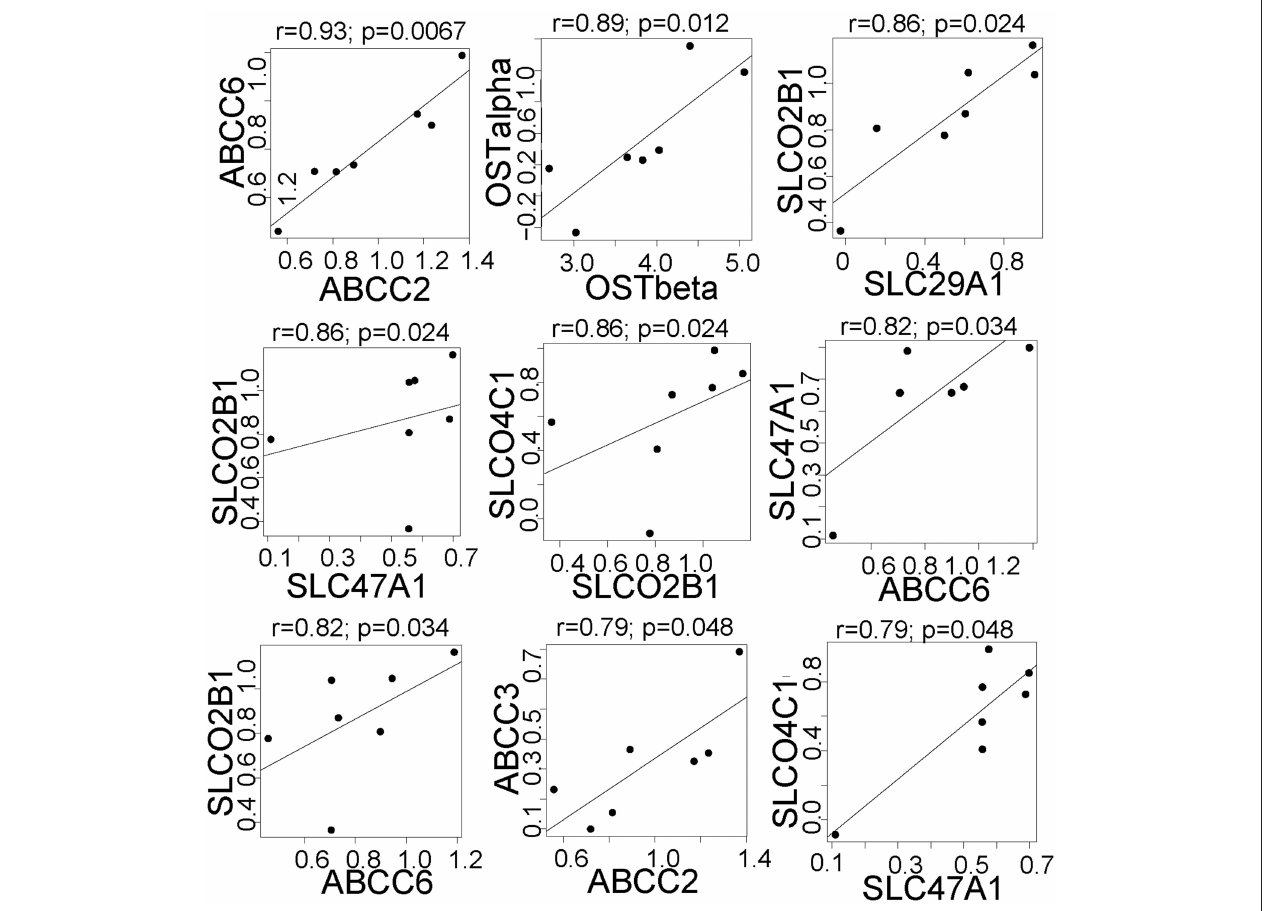
FIGURE 2 | The significant correlations between the expression of clinically relevant transporter genes that were regulated by rifampin. The expression [represented by log 2 fold change (Log 2 FC)] after rifampin treatment) was correlated for all 410 transporter genes. Only the significant correlation ( p < 0.05 by Spearman correlation) are shown for transporters regulated by rifampin with an FDR < 0.05. Spearman correlation was performed because an assumption of normal distribution could not be